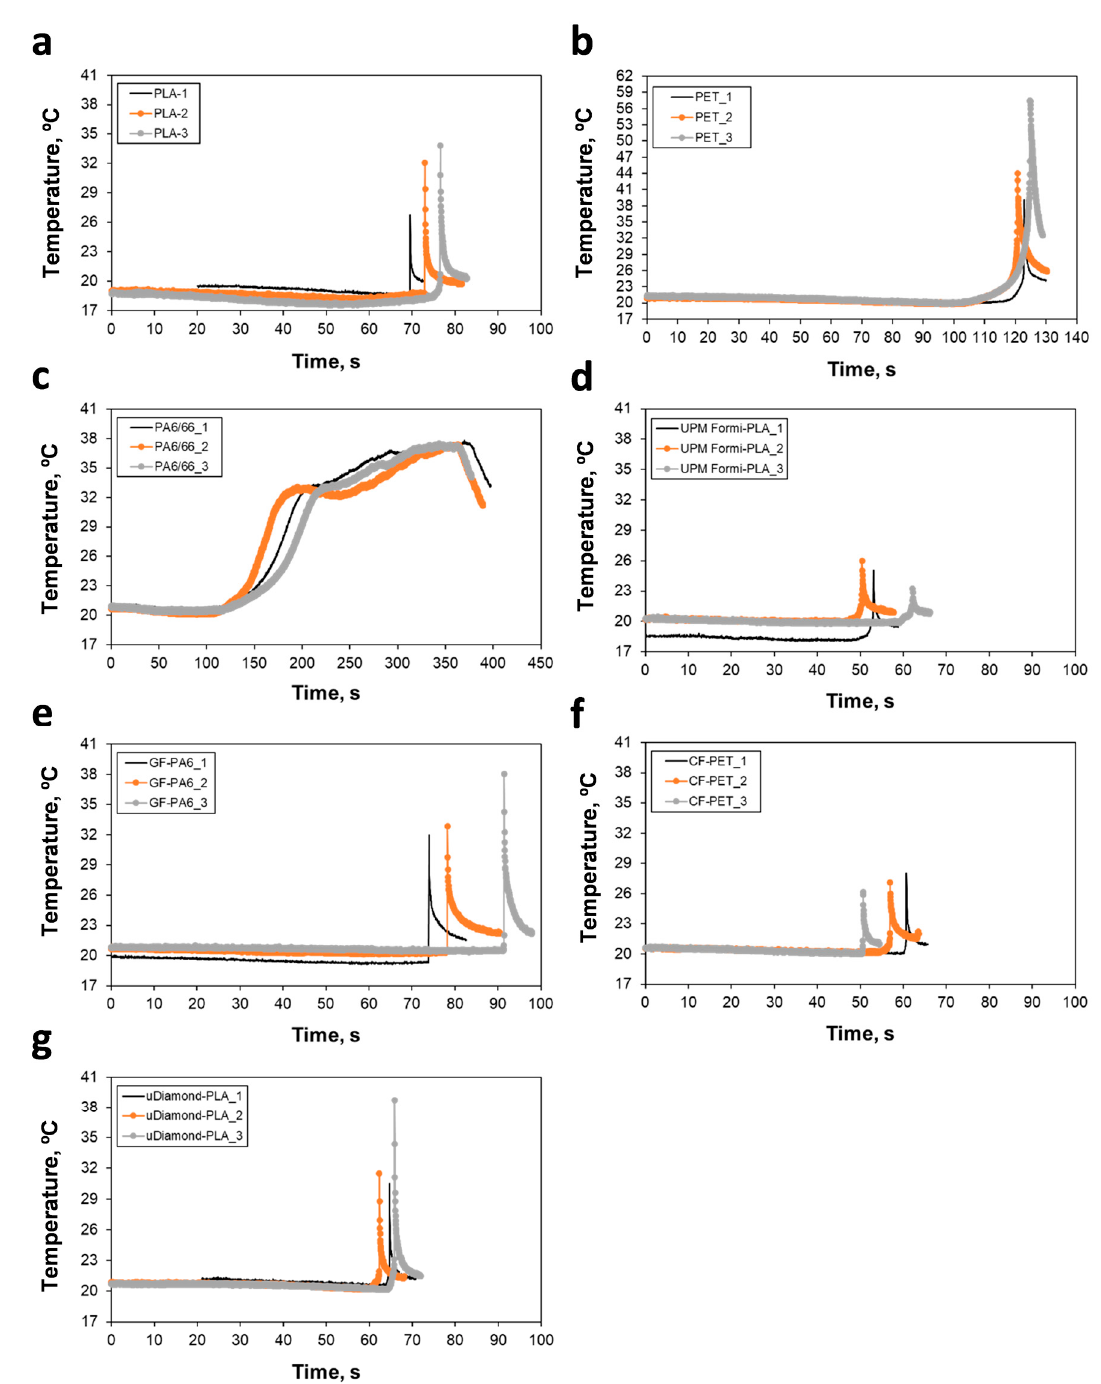
Figure 5. Temperature profiles measured during the tensile testing with IR measurement system: ( a ) PLA, ( b ) PET, ( c ) PA6/66, ( d ) UPM Formi-PLA, ( e ) GF-PA6, ( f ) CF-PET and ( g ) uDiam-PLA.